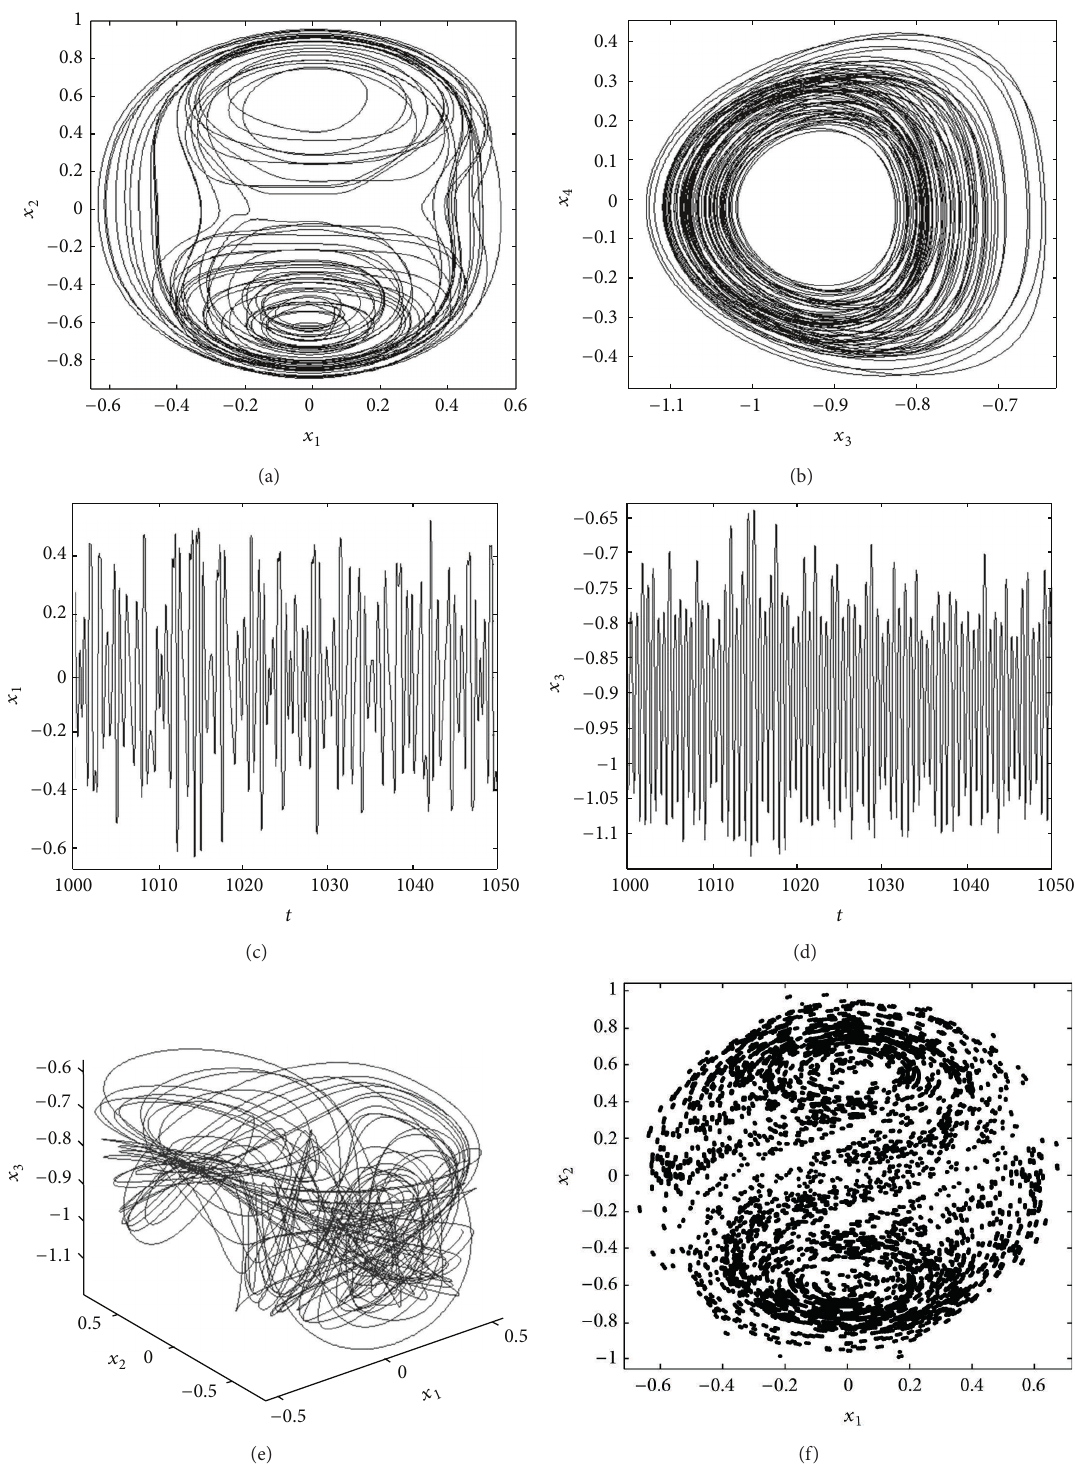
Figure 12: The multipulse chaotic motion is obtained when 𝜎 1 = 7.31 , 𝜎 2 = 12.23 , 𝜇 1 = 0.3 , 𝜇 2 = 0.2 , 𝑎 2 = 20.9 , 𝑎 3 = 13.6 , 𝑎 4 = 17.3 , = −7.37 , 𝑎 = 13.39 , 𝑓 = 35.1 , 𝑏 = −3.68 , 𝑏 = −11.16 , 𝑥 = −3.1385 , 𝑥 = −4.45 , 𝑥 = −0.59 , and 𝑥 = 0.36 ; (a) the phase portrait on 𝑎 6 7 2 6 7 10 20 30 40 the plane (𝑥 1 ,𝑥 2 ) ; (b) the phase portrait on the plane (𝑥 3 , 𝑥 4 ) ; (c) the waveform on the plane (𝑡,𝑥 1 ) ; (d) the waveform on the plane (𝑡,𝑥 3 ) ; (e) the phase portraits in the three-dimensional space (𝑥 1 ,𝑥 2 , 𝑥 3 ) ; (f) Poincare map on the plane (𝑥 1 , 𝑥 2 )